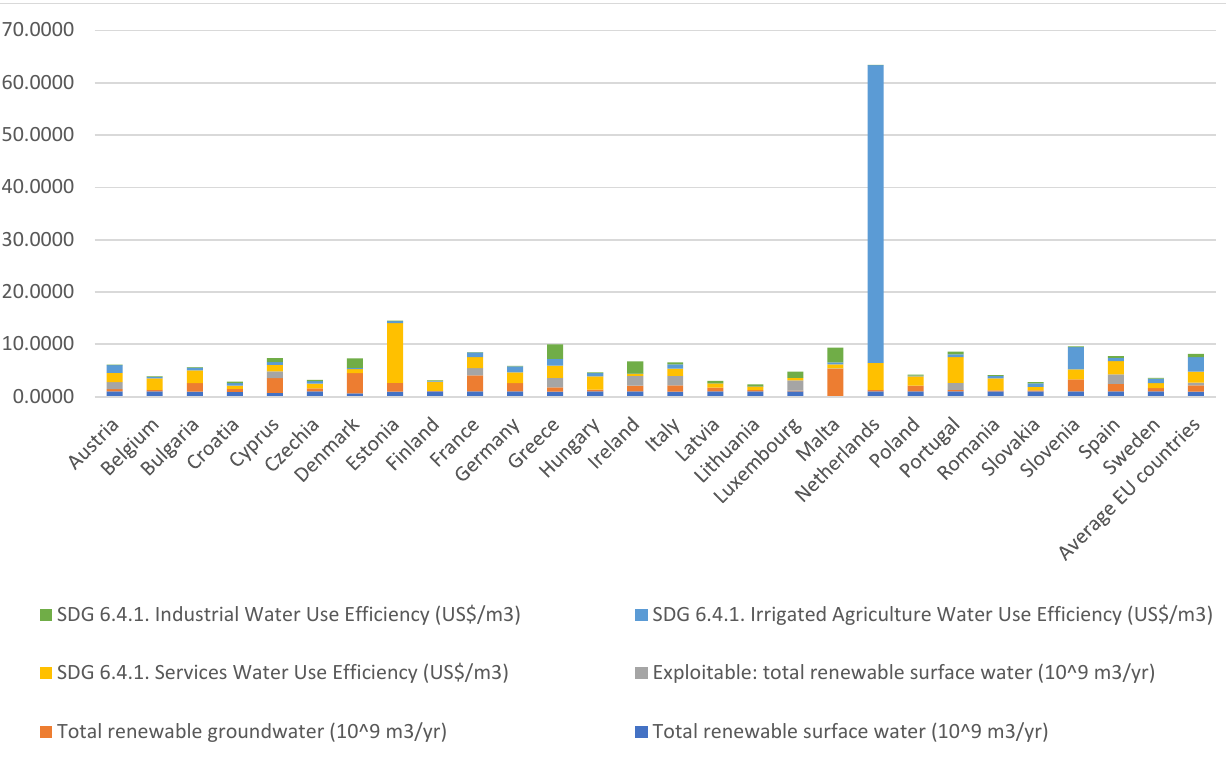
Figure 6. Sustainability inequalities indicators of EU countries.